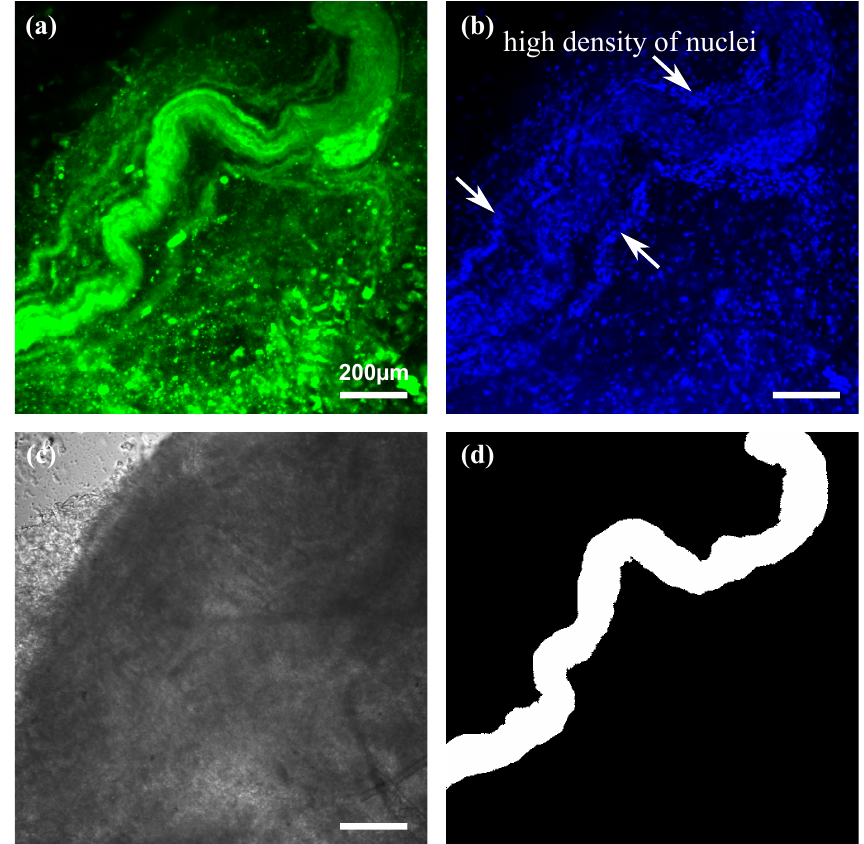
Figure 3. Confocal fluorescence microscopy imaging of rabbit peri-prostatic nerve. ( a ) FluoroMyelin TM Green image. ( b ) Hoechst image. ( c ) Transmission image. ( d ) Ground truth image prepared based on fluorescence images. Scale bar is 200 µ